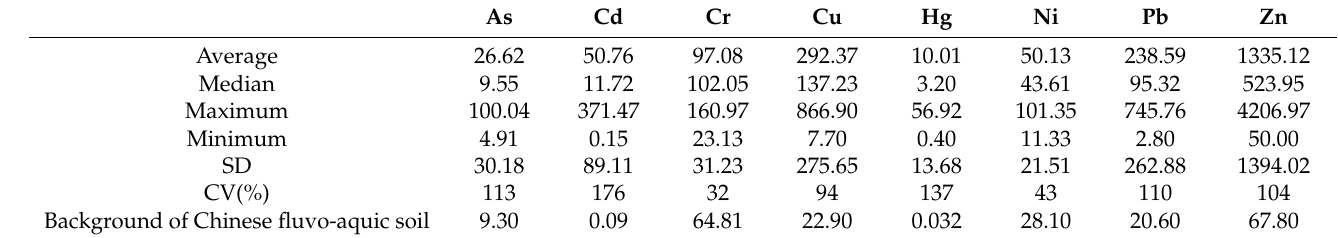
Table 4. Descriptive statistics of heavy metal concentrations (mg·kg −1 ).